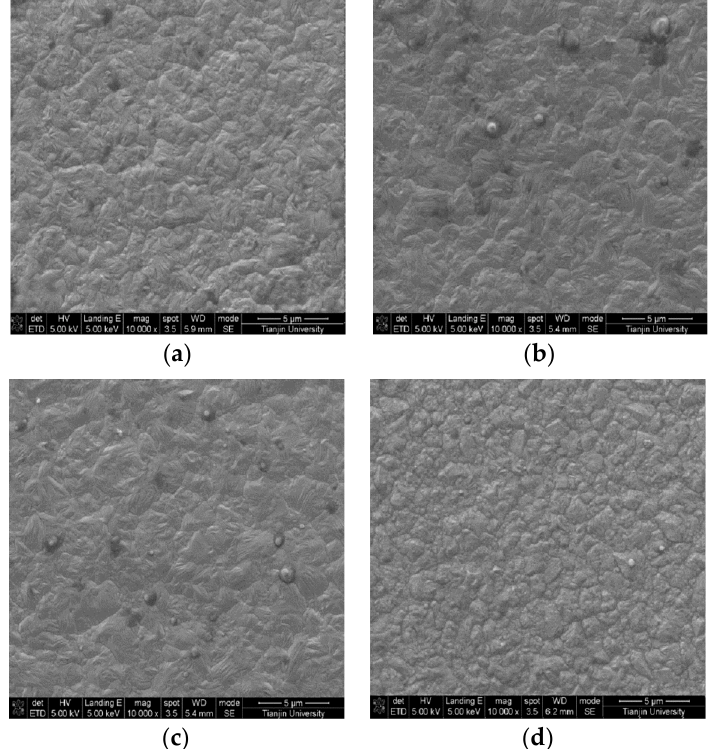
Figure 5. Scanning electron microscopy (SEM) images of the composite coating plated at various concentrations of nanodiamond particles in the plating solution from 0.8 to 16.0 g/L: ( a ) 0.8 g/L, ( b ) 4.0 g/L, ( c ) 8.0 g/L, and ( d ) 16.0 g/L.